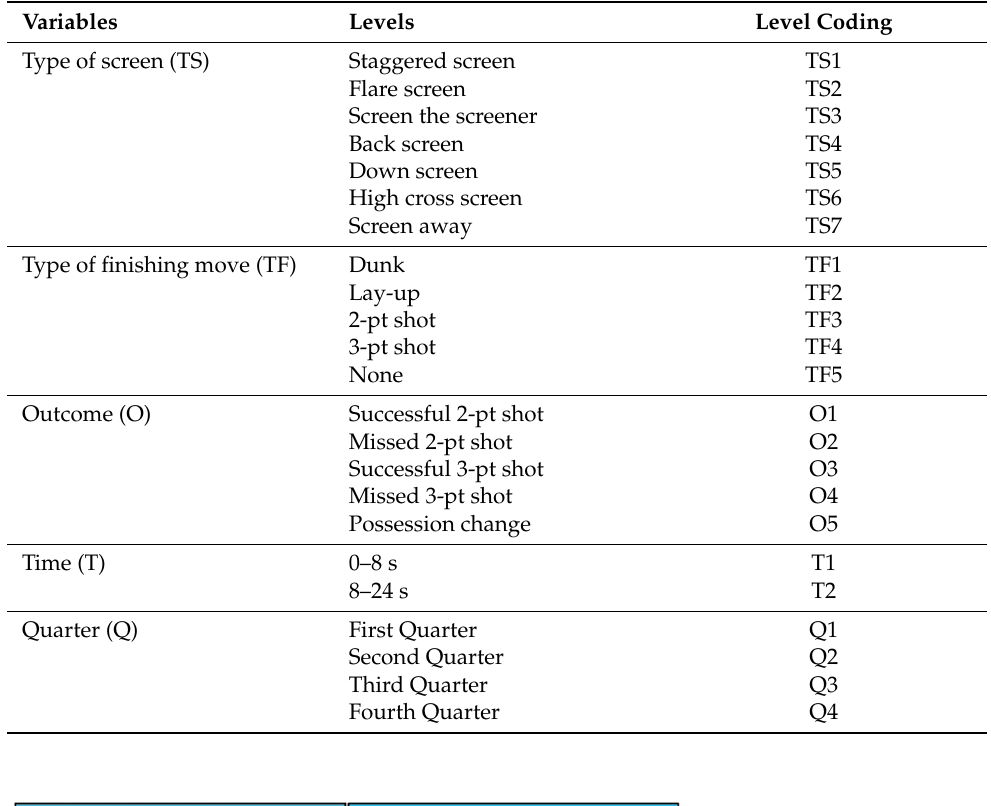
Table 2. Recorded variables, levels, and coding indices.